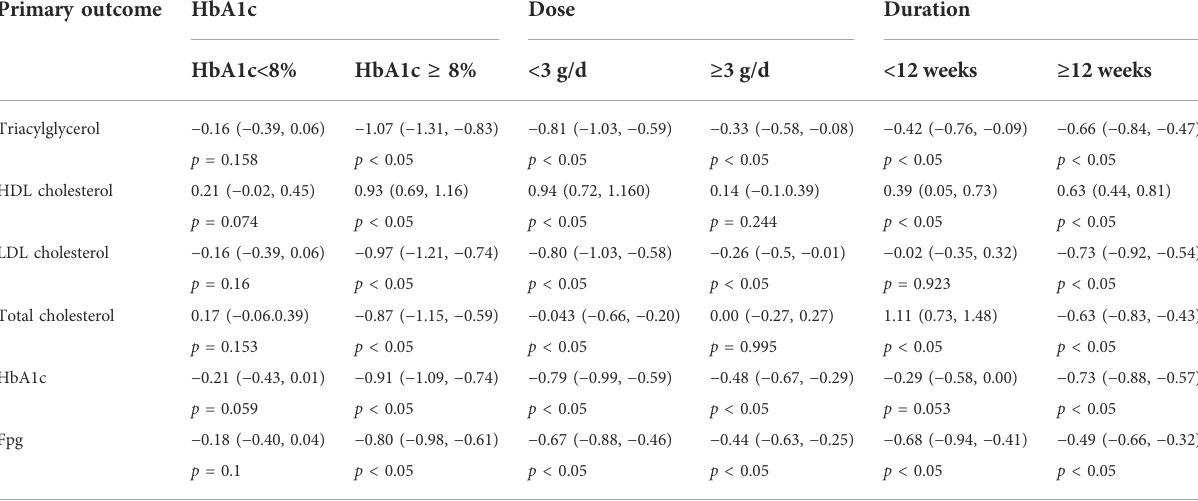
TABLE 2 Summary of subgroup analysis with random effects SMD (95% CI). *Statistically signi fi cant variables at p -value < 0.05. Primary outcome